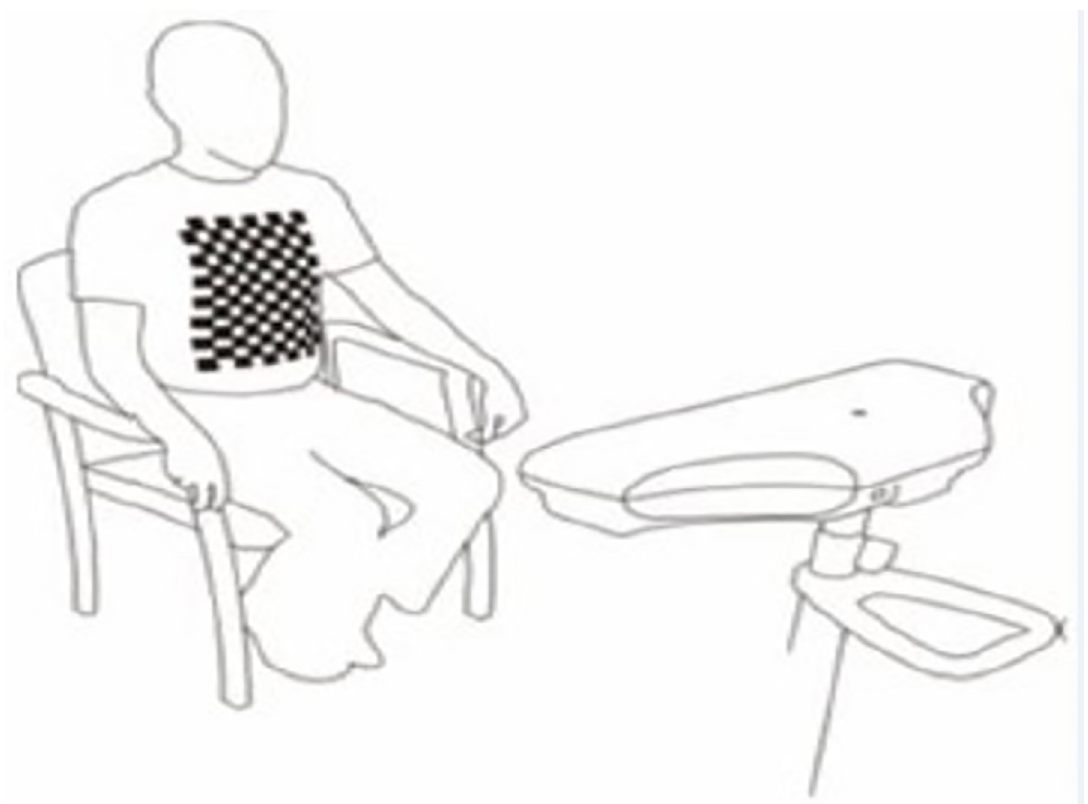
Fig 1. Structured light plethysmography in clinical use (printed with permission from